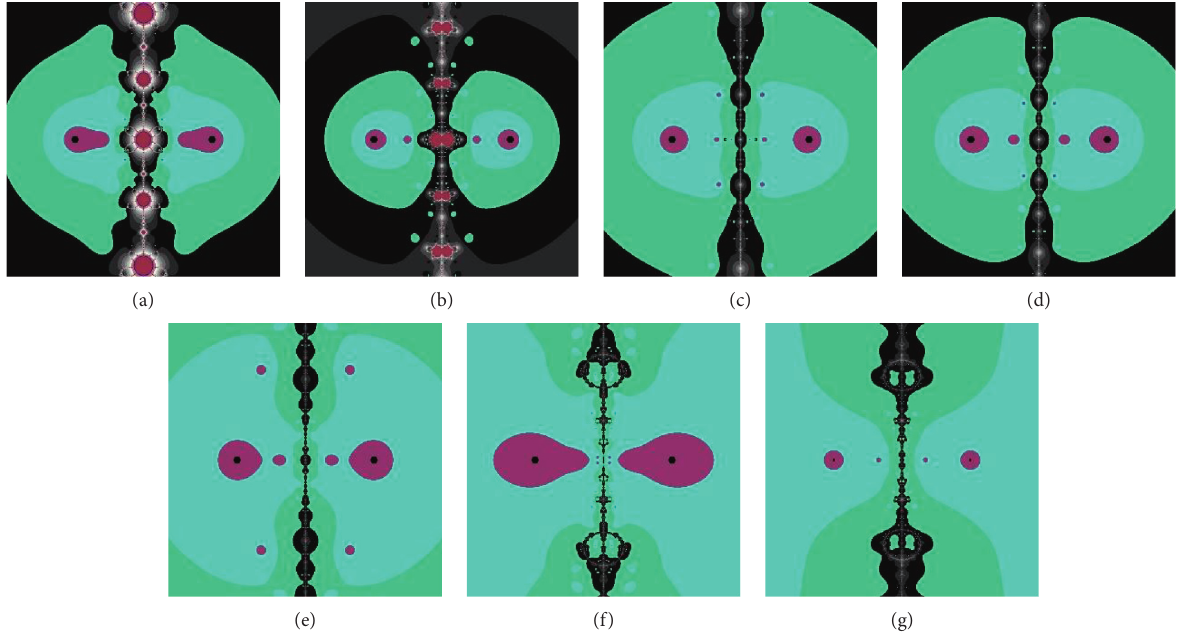
Figure 2: Polynomiographs for the polynomial p ( z ) using various iterative methods. (a) Polynomiograph for the polynomial p 2 ( z ) using NR2. (c) Polynomiograph for the polynomial p NR1. (b) Polynomiograph for the polynomial p 2 ( z ) using TM. (e) Polynomiograph for the polynomial p nomiograph for the polynomial p 2 ( z ) using Algorithm 1. (g) Polynomiograph for the polynomial p polynomial p 2